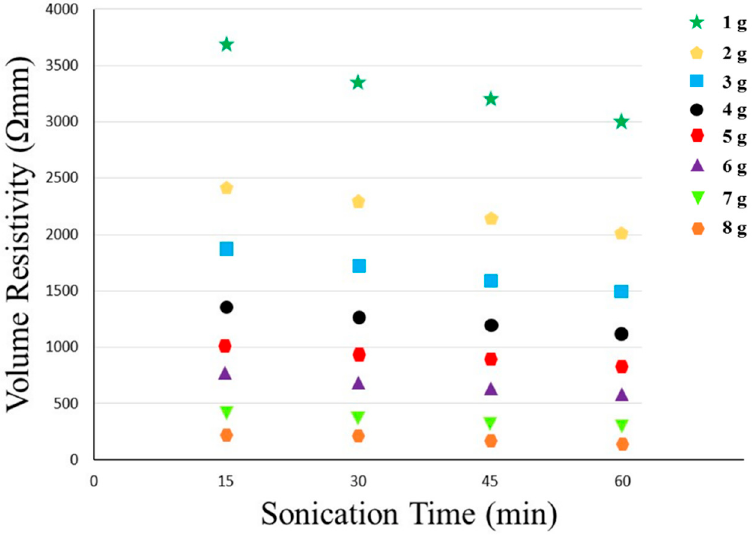
Figure 10. Effect of different concentrations of carbon particles and sonication time on electrical re- sistivity.